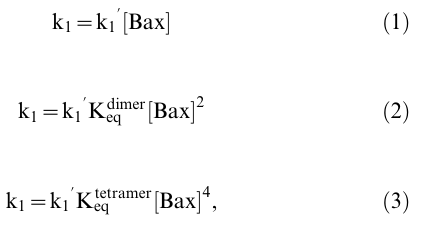
where K eq are association constants of BAX multimerization. The three panels correspond to various scenarios with K eq values ranging from high to low (top to bottom). Figure S6 Treatment of OMVs with proteinase K had no effect on kinetics of cBid/Bax-induced dextran release, but 68 u C heat treatment of OMVs inhibited Bax-induced dextran release; Drp1 was undetectable in highly enriched mitochondrial fractions. (A) OMVs (24 m g of protein) were incubated with 80 or 160 m g/ml proteinase K for 20 min at 37 u C, followed by an addition of 0.5 mM PMSF (phenylmethanesulfonylfluoride). OMVs were washed twice by centrifugation and resuspended in the standard assay buffer. Dextran-fluorescein release from control (blue lines) and proteinase K-treated OMVs (green and red lines) was induced by 40 nM cBid and 100 nM Bax. (B) Western blot analysis of selected protein degradation by proteinase K. (C) Dextran release from control (black lines) and 68 u C heat-inactivated OMVs (red lines) was induced by 100 nM Bax in the presence of 80 nM BimS; note that BimS produced a lag similar to that seen with cBid. At elevated temperatures (45 u C), Bax (100 nM) caused dextran release in the absence of cBid or BimS, after a lag phase (D). Arrows indicate additions of Bax; when present, BimS was added 2 min prior to Bax. (E) Western blot analysis did not detect Drp1 in rat liver OMVs and isolated mitochondria. Samples of OMVs and rat liver mitochondria were loaded at 10 m g of protein. As positive controls, cell lysate from rat neural cells (1RB 3 AN 27 ) was loaded at 10 m g of protein, and purified recombinant Drp1 (rDrp1) was loaded at 4 and 10 ng. (F, G) Drp1 and Bif-1 were readily detected in Xenopus Egg cytosol but not in the mitochondrial fractions. Mitochondrial and cytosolic fractions isolated from Xenopus eggs were loaded at 30 m g (F) or 10–14 m g (G) of protein. Recombinant Bif-1 (rBif-1) was loaded at 27.5 ng. No Bif-1 band was detected in Xenopus Egg OMVs (G). Figure S7 Effect of temperature on membrane fluidity. (A) Model membrane system exhibiting a phase transition, reflected in a marked change in membrane fluidity. To assay membrane fluidity, DPH fluorescence polarization (FP) was measured in artificial liposomes prepared from 1-myristoyl-2-palmitoyl-sn- glycero-3-phosphocholine (MPPC), a lipid with a well-defined transition temperature (35 u C; Avanti Polar Lipids, Inc.). A sharp change in FP was observed in the 35–37 u C range, reflecting a large-scale gel-to-liquid crystalline phase transition. Data shown are replicate samples (black and grey lines). (B) FP was measured in DPH-labeled isolated mitochondria (blue line) and OMVs (red line) as a function of temperature. FP is reciprocally related